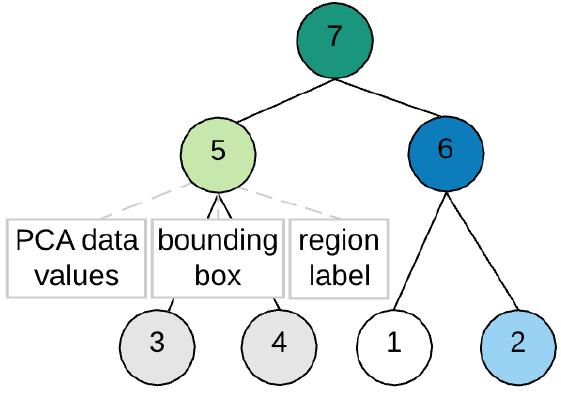
Figure 3. Example of a BPT pruned tree after embedding.